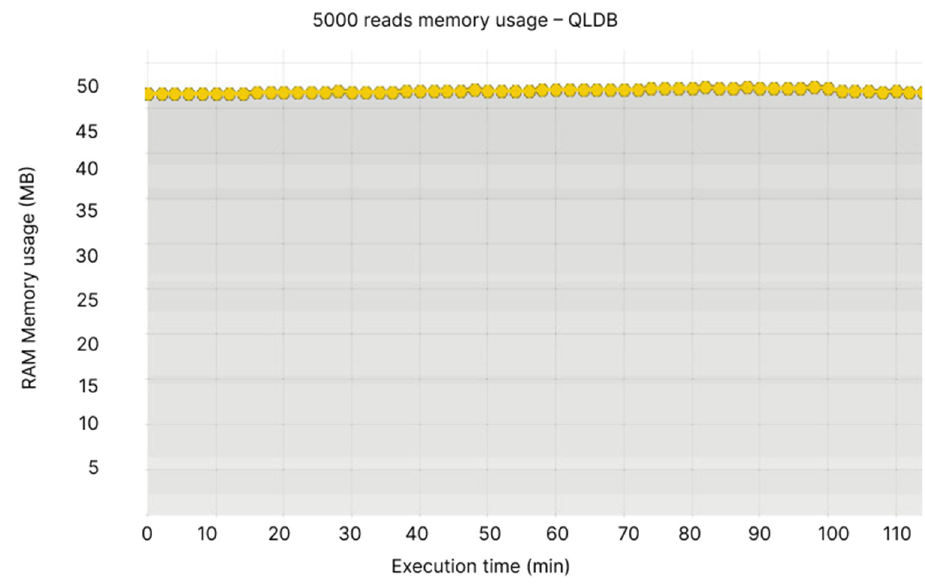
Figure 25. 5000 reads memory usage—QLDB.